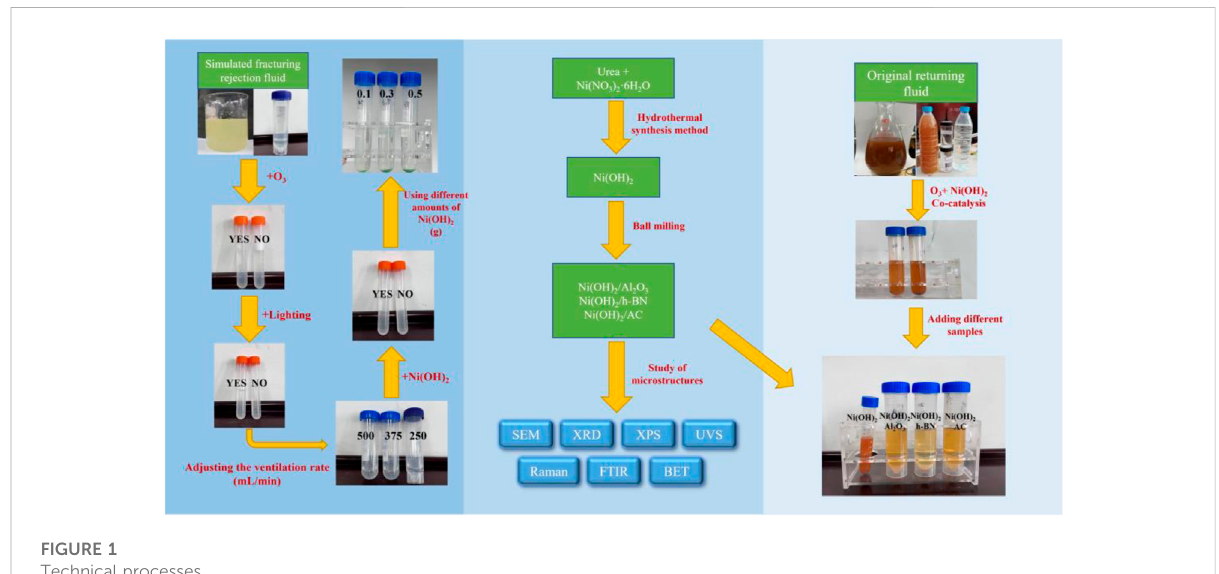
FIGURE 1 Technical processes.